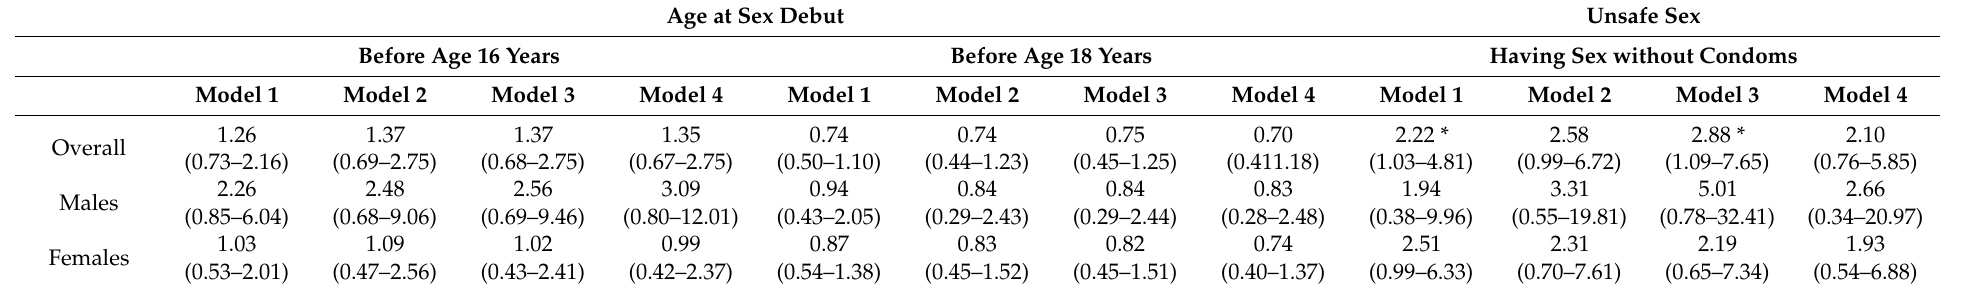
Table 5. Multinominal regression analysis on the association between gender contentedness and age at sex debut and unsafe sex, OR